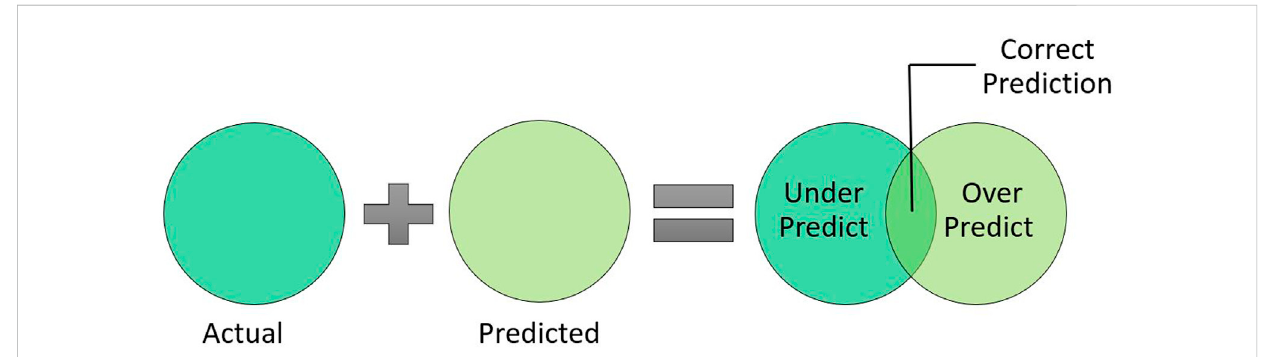
FIGURE 3 Schematic diagram of land loss accuracy assessment.